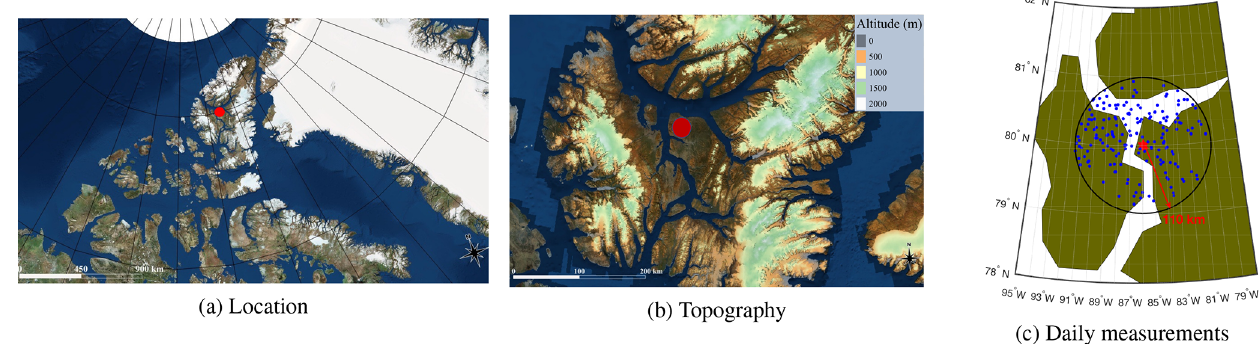
Figure 8. (a) Geographic map showing the location of PEARL at Eureka, Nunavut, Canada. (b) Topography around PEARL. (c) Example of daily MOPITT CO measurements near Eureka on 20 July 2007 within a 110km radius. In all figures, the red dot indicates the location of the PEARL Ridge